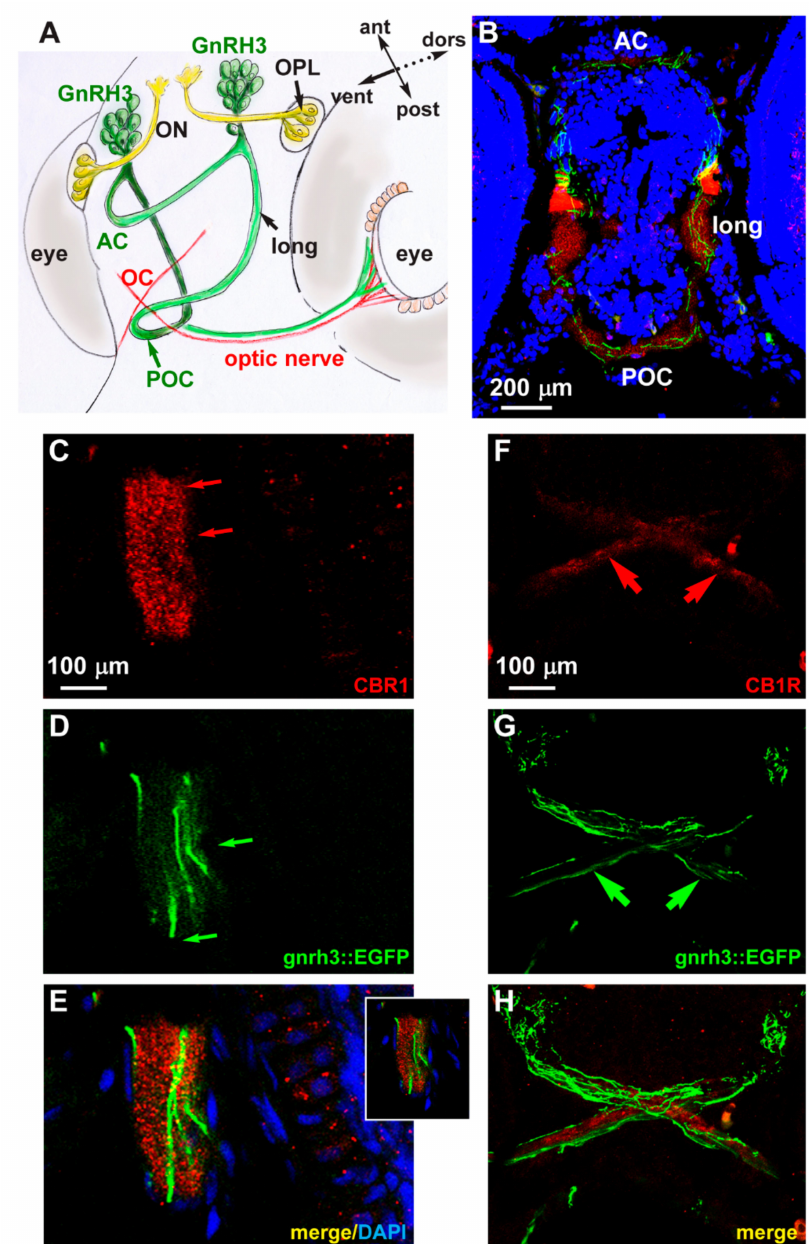
Figure 4. Expression of CB1R in developing zebrafish brain. ( A ) Scheme illustrating the position of the GnRH3 neurons relative to the position and orientation of the main forebrain commissure in the zebrafish brain (redrawn from [52]). ( B ) Low magnification double-fluorescent images of GnRH3::EGFP neurons (green) and IFL with an anti-CB1R antibody (red) on cryostatic sections of the zebrafish head at the age 72 hpf. ( C–E ) Higher magnification double-fluorescence images of the anterior commissure, showing overlapping localization of CB1R punctate staining (red) with EGFP + fibers (green). Sections were counterstained with DAPI (blue). The merged signal is shown in E . Inset in E shows a single stack of the same image. Arrows indicate the fluorescence signal. ( F – H ) Higher magnification double-fluorescence images of the optic chiasm, immunostained for CB1R (red), as in panels C – E . Adjacent but non-overlapping expression was observed in these fibers. Arrows indicate the fluorescence signal. Scale bars are reported in panels B , in C (for C , D ) and in F (for F – H ). AC, anterior commissure; ant, anterior; dors, dorsal; long, longitudinal tract; OC, optic chiasm; ON, olfactory nerve; OPL, olfactory placode; POC, postoptic commissure; post, posterior; RGC, retinal ganglion cells; ven,